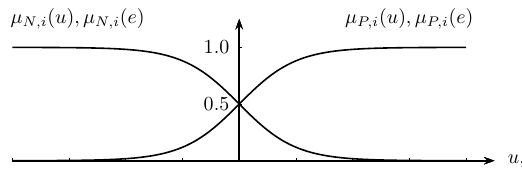
Figure 23. Membership functions